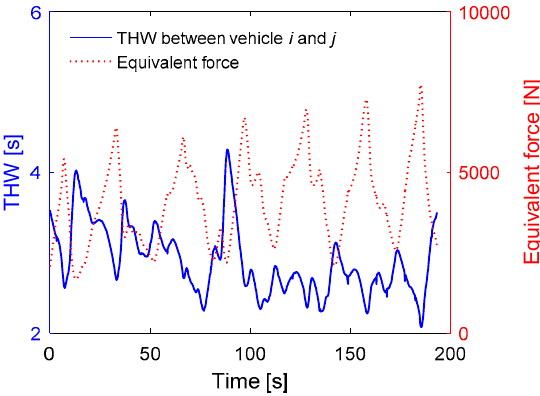
Figure 13. Experiment result in the cut-in scenario.